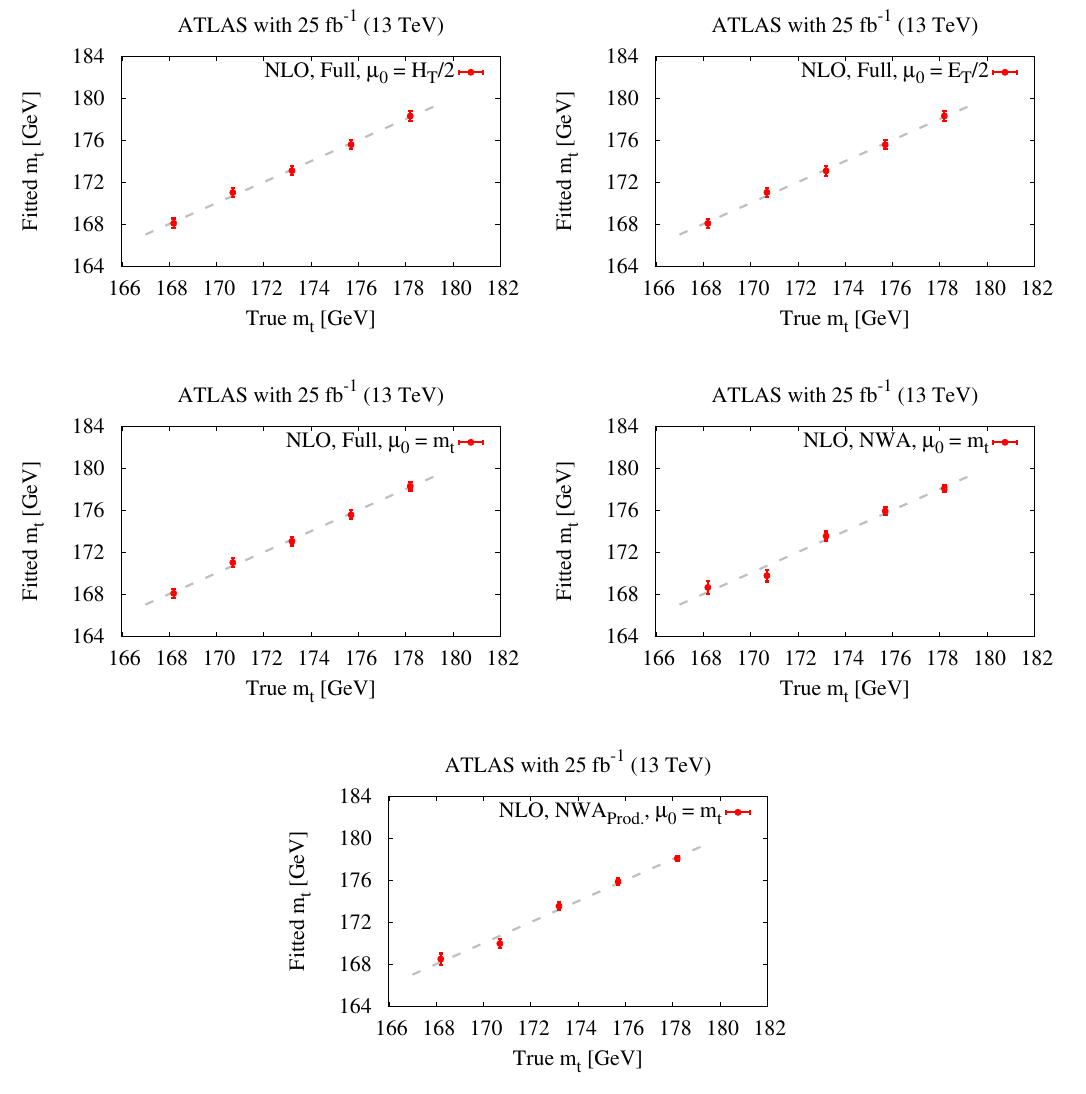
Figure 12 . A di(cid:11)erence between the (cid:12)tted top quark mass and the top quark mass assumed in the theoretical prediction used for the generation of the pseudo-data set. The ATLAS binning is assumed. Luminosity of = 25 fb (cid:0) 1 is considered and the CT14 PDF set is employed. The grey L (dashed) line corresponds to "Fitted m t " = "True m t